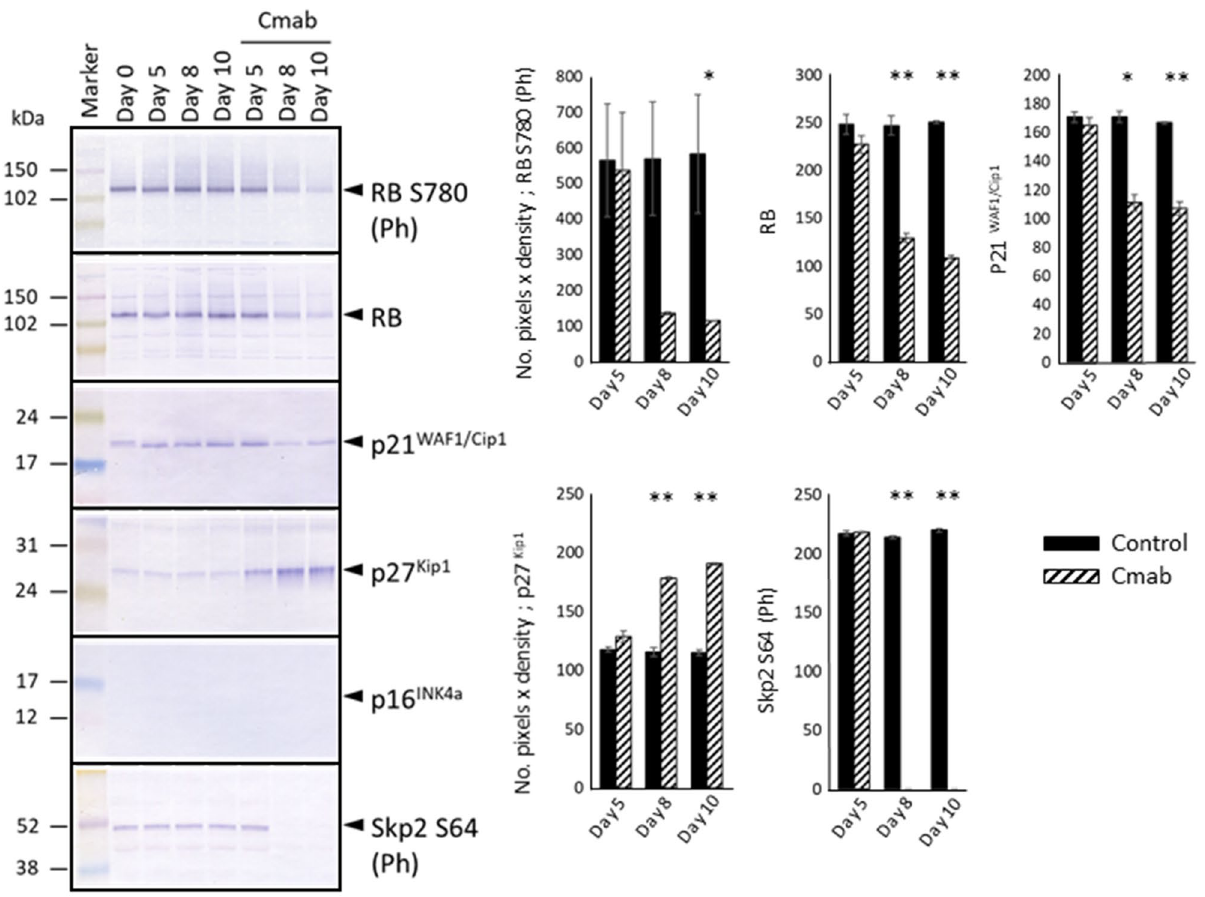
Figure 6. RB and phosphorylated-RB protein levels decreased considerably after 8 or 10 days of cetuximab treatment. Thus, the expression levels of other CKIs were investigated. The p21 protein-expression level decreased as well. The p16 protein was not detected in control- or cetuximab-treated SAS-Fucci cells. Instead, strong p27 Kip1 expression was detected in SAS-Fucci cells treated with cetuximab (10 µg/mL) for 5 days. This examination revealed that prolonged cetuximab treatment inactivated the phosphorylation and function of Skp2. Those expression levels were evaluated with the number of pixels × density and analyzed with t test (control- versus cetuximab-treated group). The experiment was repeated 3 times. * p < 0.05, ** p < 0.001.